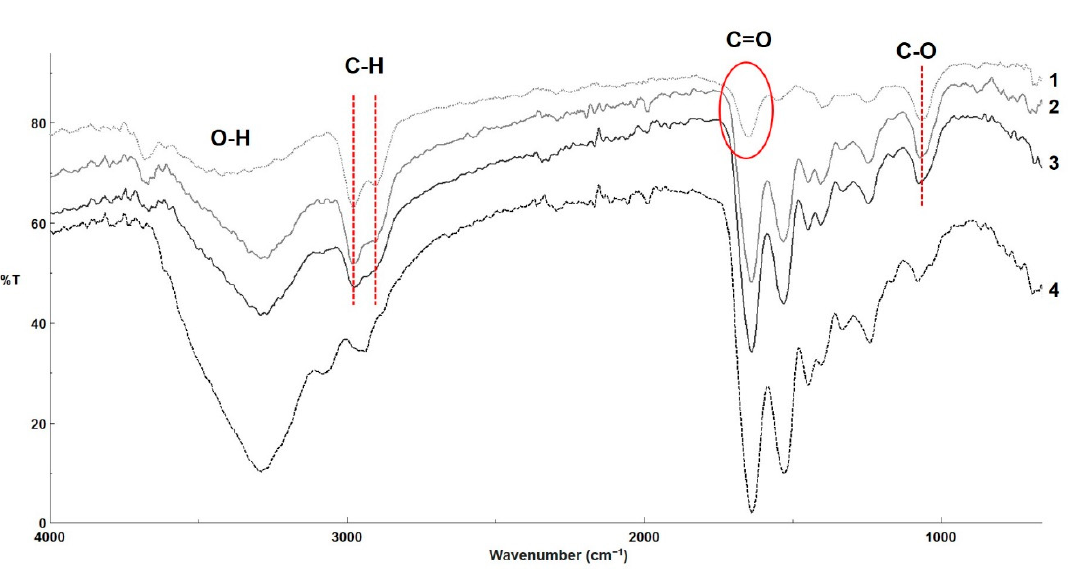
Figure 5. FT-IR spectra recorded on control samples: 1—NDs, and 4—FG and on the fibrous scaffolds 2—FG_ND 1%, 3—FG_ND 0.5% (increasing amount of NDs intensifies the specific vibrations